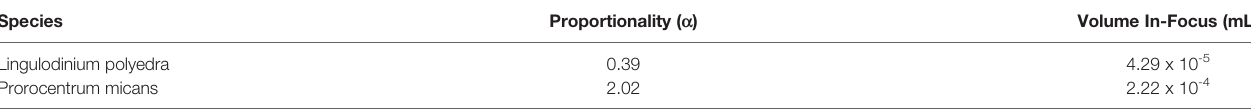
TABLE 3 | Calibrated SPC+CNN-Pier Sampling Volume Per